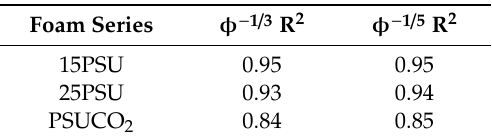
Table 3. Coe ffi cient of correlation for fitting curves corresponding to the corrected electrical conductivity ( σ *) as a function of φ − 1 / 3 and φ − 1 / 5